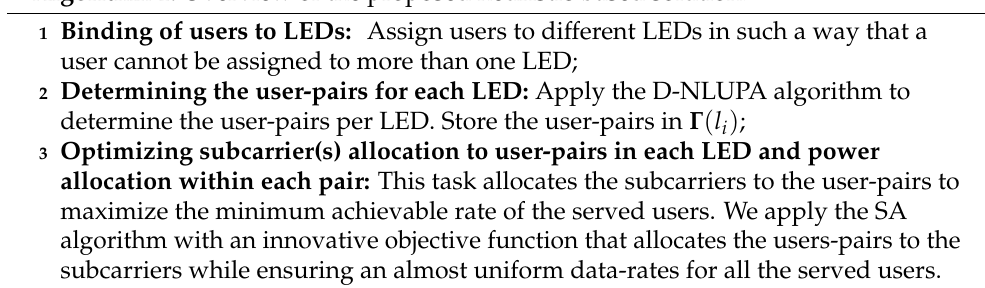
Algorithm 1: Overview of the proposed heuristic-based